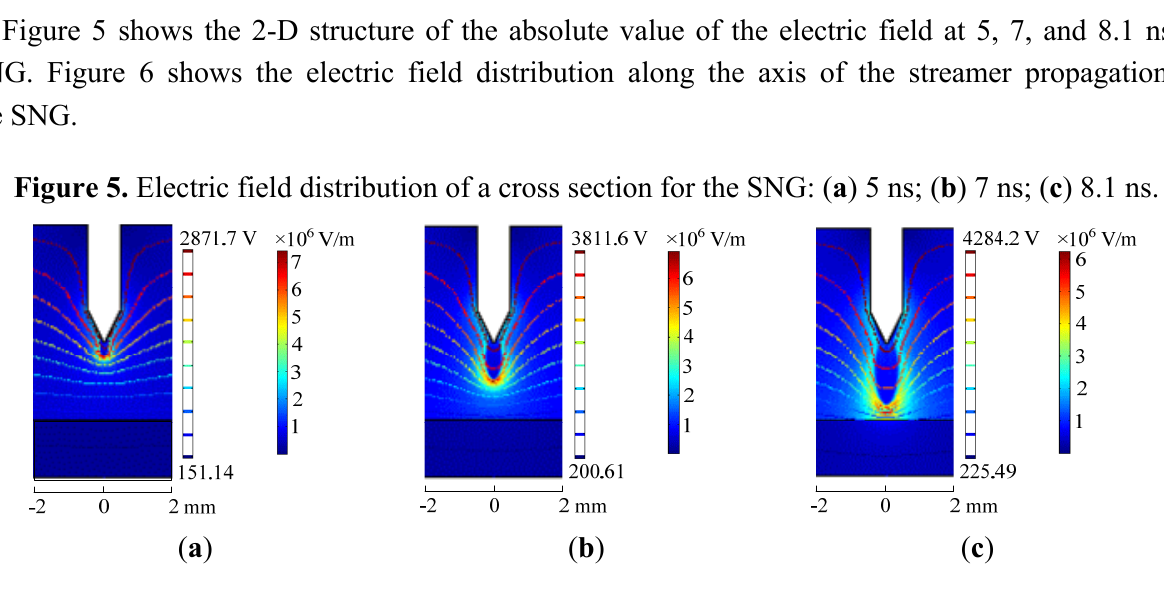
Figure 6. Electric field distribution along the axis of the streamer propagation of the SNG at different